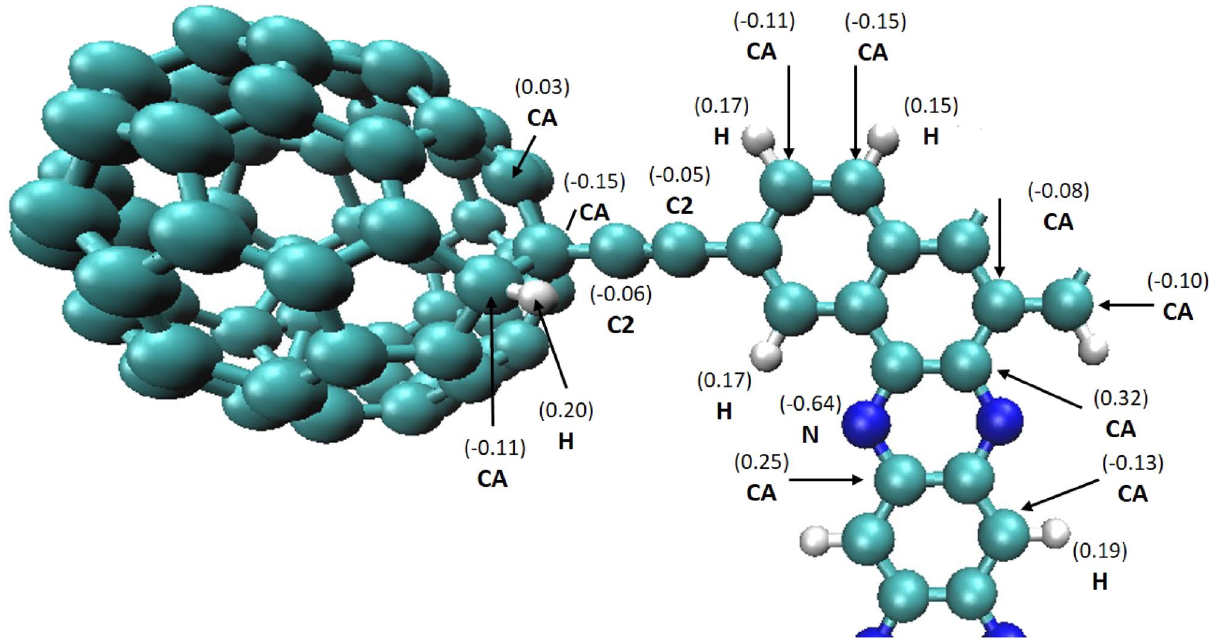
Figure 4. Different types of carbon atoms and charge distribution considered in the